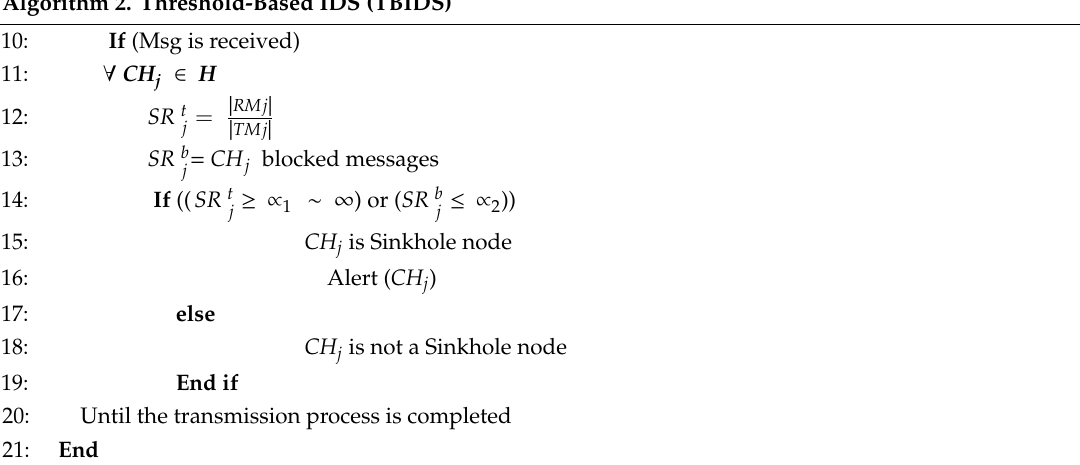
Algorithm 2. Threshold-Based IDS